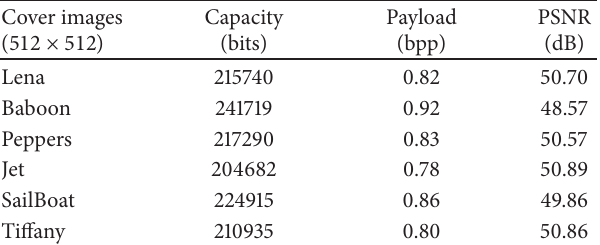
Table 5: The experiment results use Figure 4 as the cover image. Cover images (512 ×